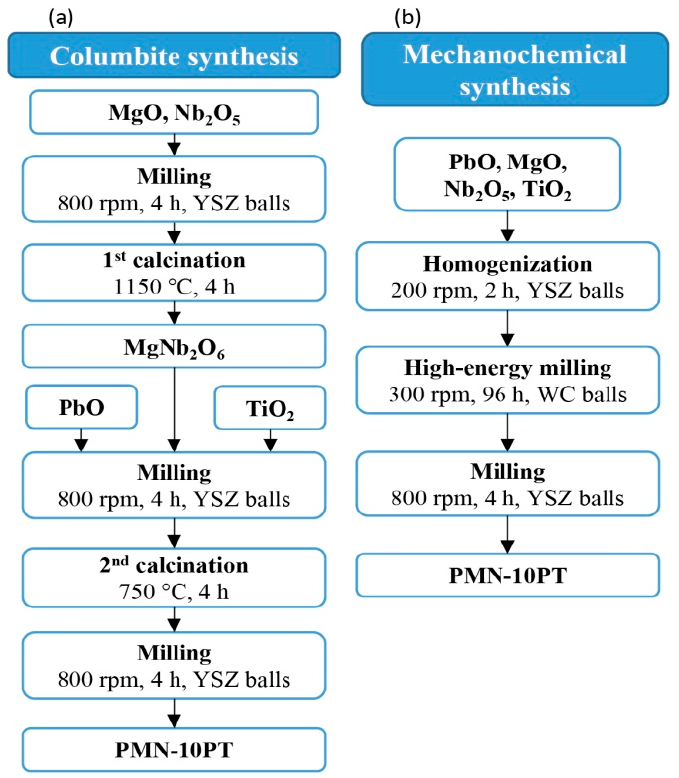
Figure 1. Schematic presentation of the ( a ) columbite and ( b ) mechanochemical syntheses of the PMN-10PT ceramic powder.